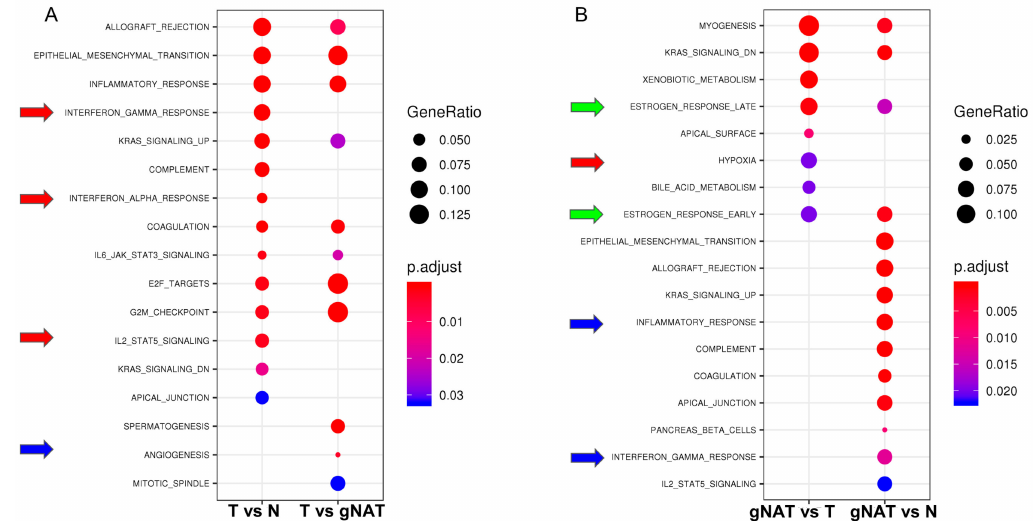
Figure 3. Gene set analysis (GSA) of the hallmark gene sets using the di ff erentially expressed genes (DEGs) between tumor or gNAT vs. each of the other two tissues, respectively. Adjusted p -value in red-blue color scale. Gene ratio in dot size scale. Red, blue and green arrows highlight interesting exclusive and common gene sets, respectively. ( A ) Tumor centered analysis, ( B ) gNAT centered